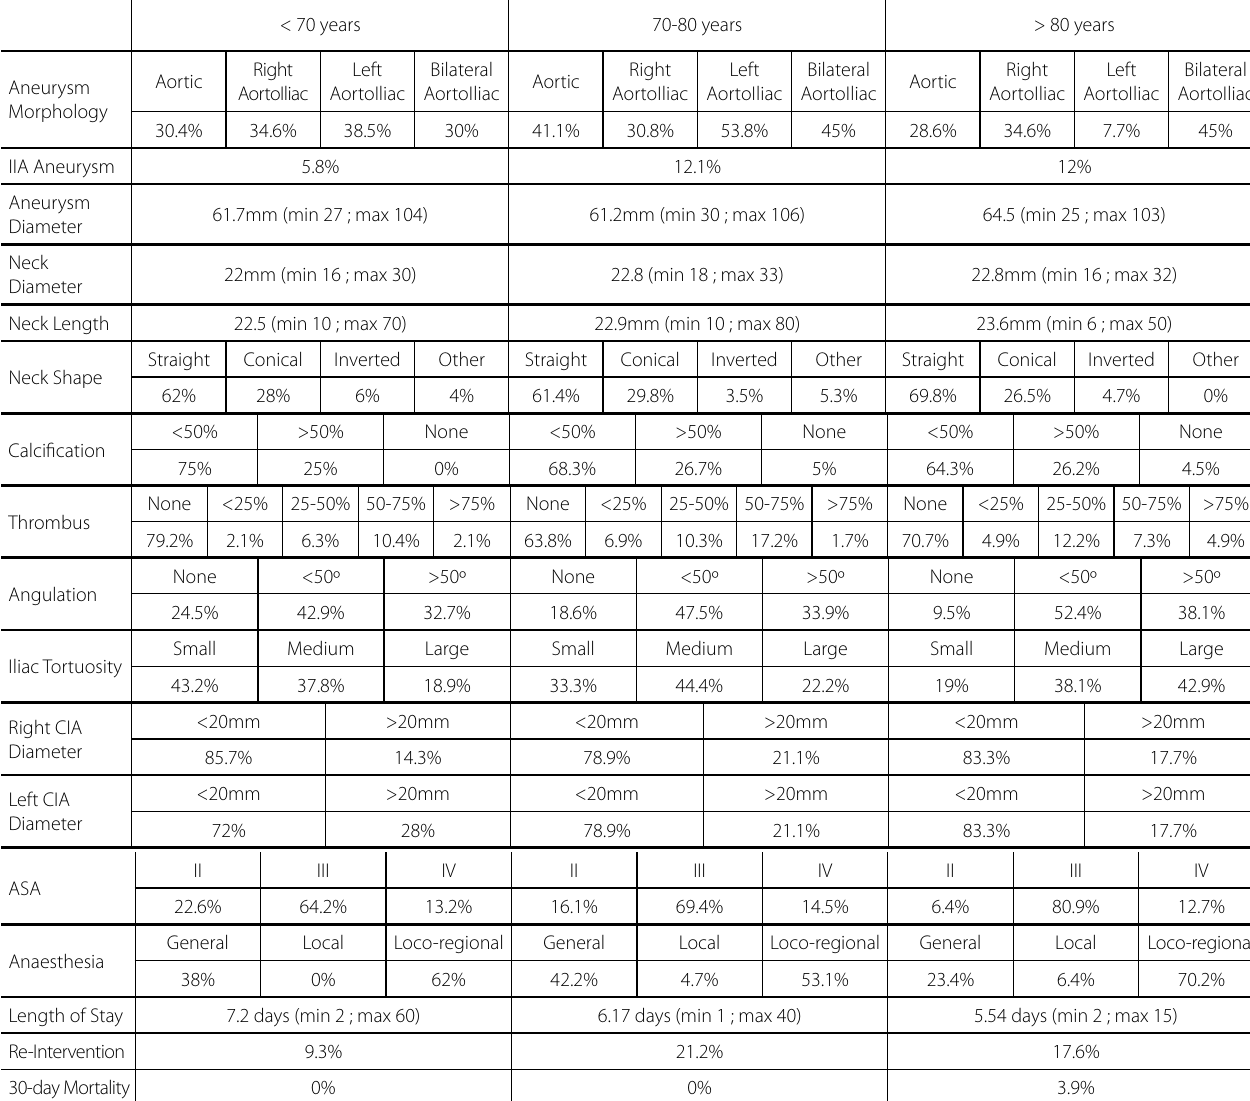
Table 1. Pre, intra and postoperative data. No statistical significance. IIA, Internal Iliac Artery; CIA, Common Iliac Artery; ASA, American Society of Anaesthesiologists